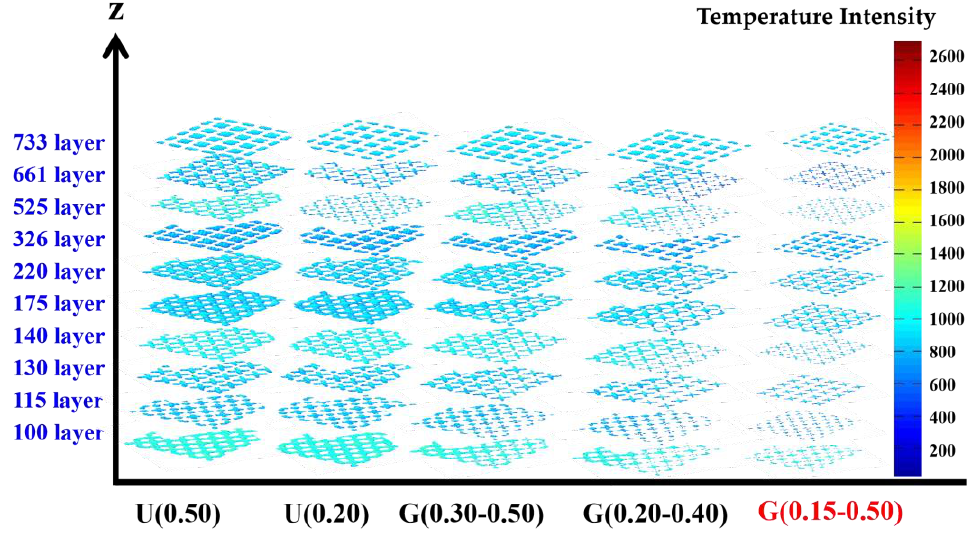
Figure 4. Temperature intensity distribution of lattice structures monitored by MPM module.